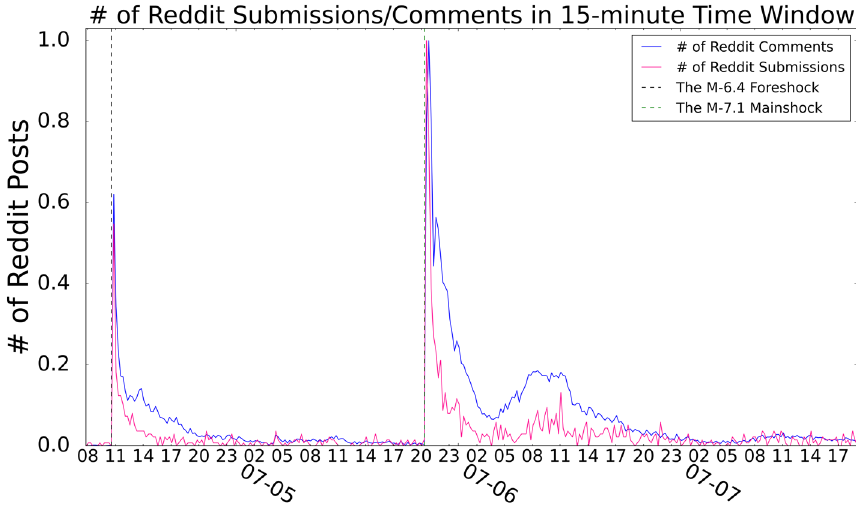
Figure 2. Number of earthquake-related posts from the Reddit RC/RS datasets (the numbers are normalized, i.e. 1.0 means the peak number of earthquake-related posts in RC/RS). 1437 submissions and 44,333 comments are included in the